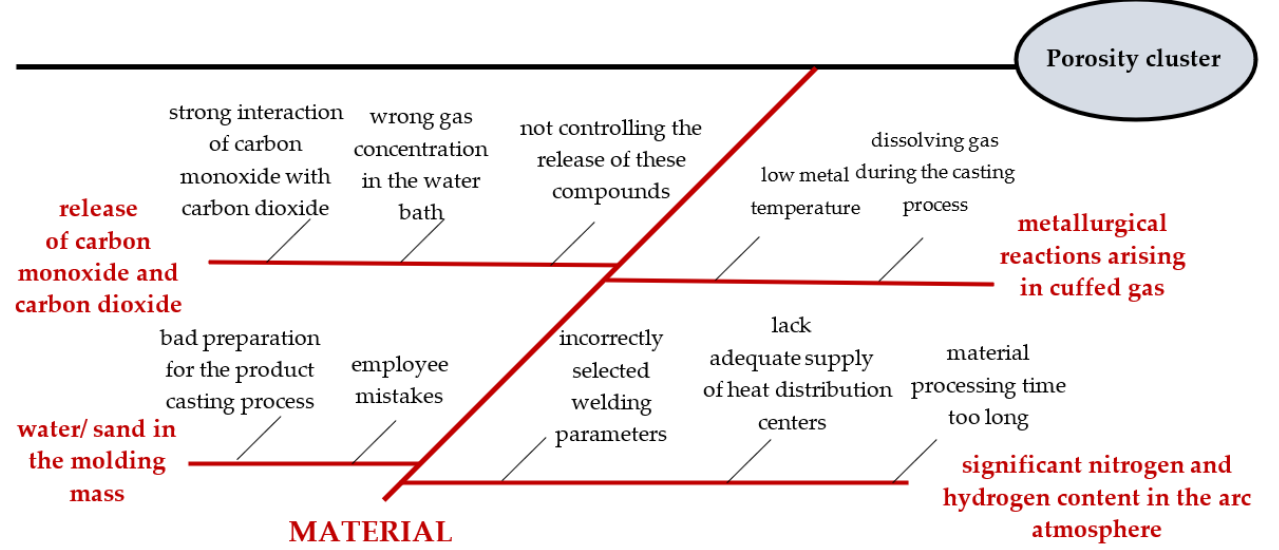
Figure 6. Fragment of the Ishikawa diagram for the “ material ” category.